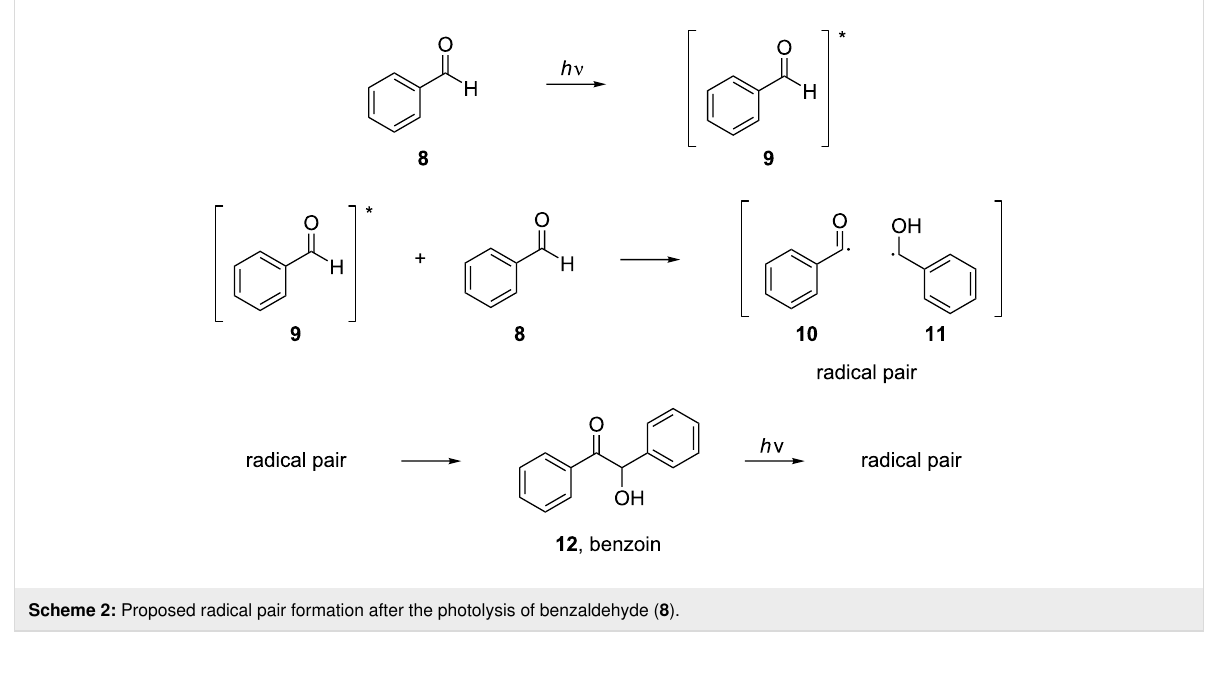
energy-state olefin via a Paterno–Büchi reaction, indicating that benzaldehyde ( 8 ) can have an EnT ability comparable to that of known photocatalysts, such as aryl ketones (Scheme 3) [15-17]. Later, Steel and co-workers examined the photochemical prop- erties of benzaldehyde ( 8 ), studying the EnT from 8 to azo com- pounds [18]. Upon the irradiation and excitation of benzalde- hyde ( 8 ), the phosphorescence was quenched either by the for- mation of the radical pair mentioned in Scheme 2 or by a triplet state-energy acceptor, such as 2,3-diazabicyclo[2.2.1]hept-2-ene (DBH, 18 , Scheme 4). Trying to shed more light on the photolysis of benzaldehyde, Atkins and co-workers studied the photolysis of benzaldehyde ( 8 ) with electron spin resonance flash photolysis (ESRFP) and CIDNP in various solvents, depending on the efficiency of the solvents as hydrogen donors [19]. More specifically, triplet state